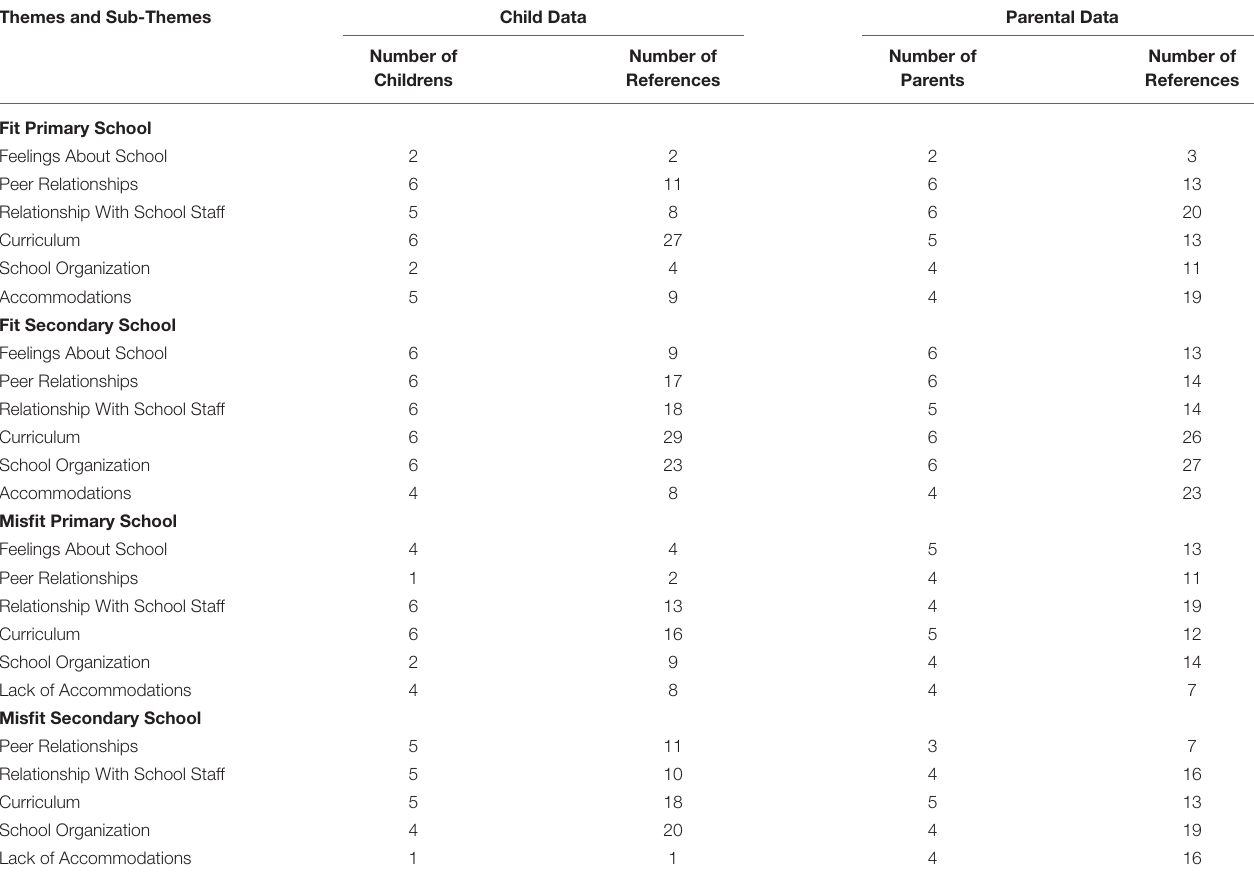
TABLE 1 | Number of Child/Parent References per